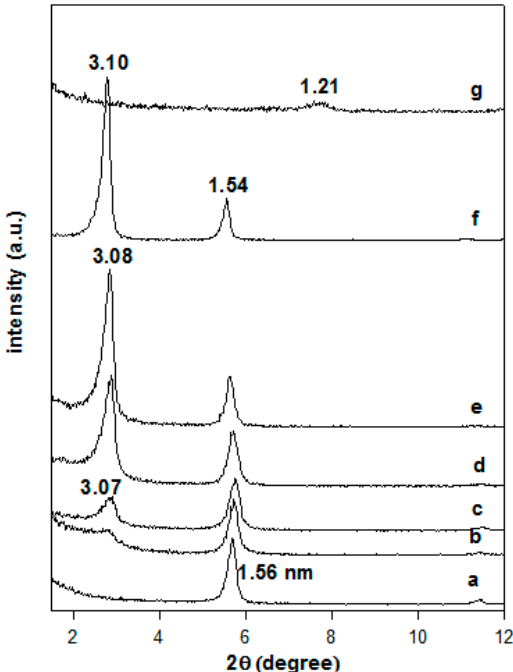
Figure 3. Powder XRD patterns of ( a ) Na-magadiite treated with different C16TMABr concentrations. ( b ) 0.20 mM, ( c ) 0.40 mM, ( d ) 0.80 mM, and ( e ) 1.20 mM, and ( f ) corresponds to organo-magadiite